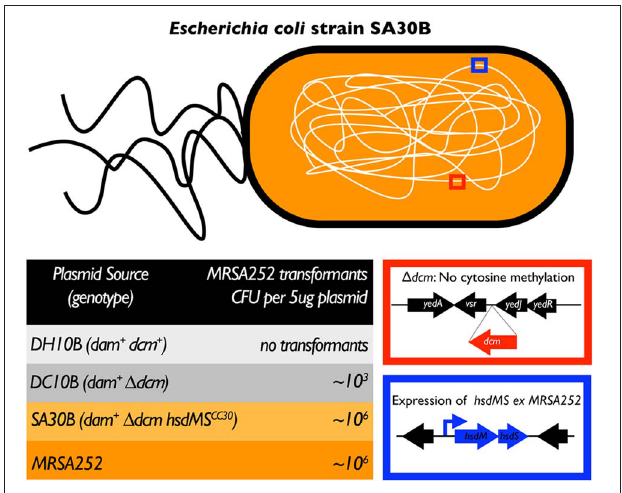
FIGURE 1 | Plasmid artificial modification—application to staphylococci. In a cloning strain of E. coli (DH10B), the chromosome was manipulated by recombineering to develop a host for the maximal efficiency of plasmid transfer into the target staphylococcal strain. To bypass the type IV restriction system, the dcm gene was deleted resulting in a loss of cytosine methylation (red box), creating strain DC10B. Secondly, the hsdMS genes of the target staphylococcal strain, under the control of a strong promoter (blue box) were introduced onto the chromosome of DC10B at a neutral site forming, for example. E. coli strain SA30B—with hsdMS genes derived from MRSA252 (clonal complex 30). A shuttle plasmid was isolated from each E. coli strain described above and S. aureus MRSA252. Five micrograms of shuttle plasmid was transformed into MRSA252 with the CFU enumerated after growth on antibiotic-containing selective agar (bottom left